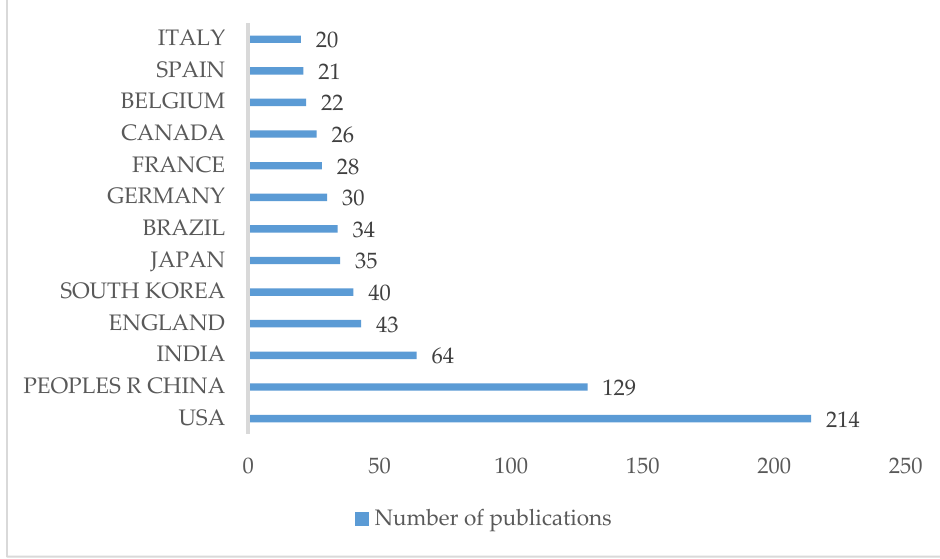
Figure 5. Countries with the highest number of publications.